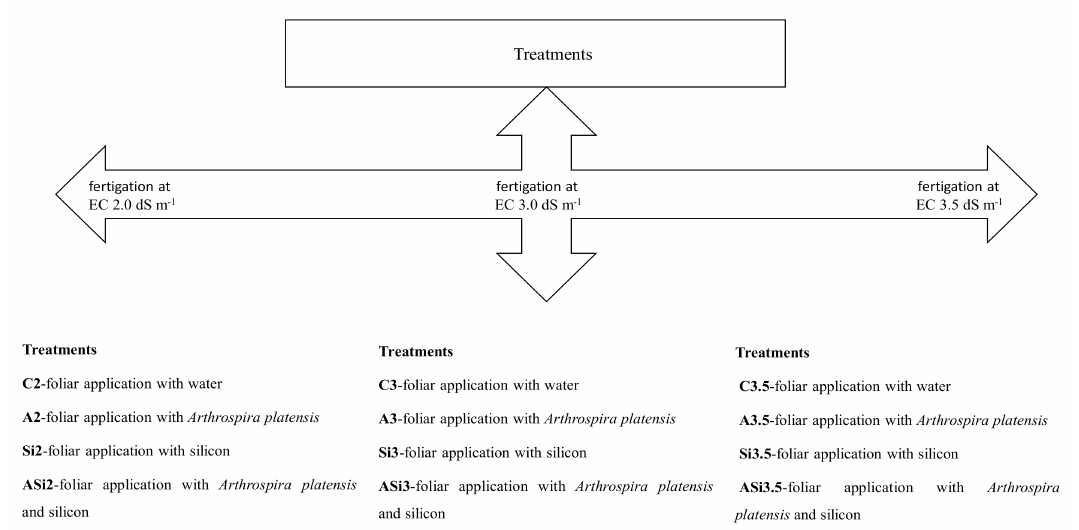
Figure 1. Schematic diagram of the treatments performed. C—foliar application with water; A—foliar application with Arthrospira platensis ; Si—foliar application with silicon; ASi—foliar application with Arthrospira platensis and silicon; 2—fertigation at EC 2.0 dS m − 1 ; 3—fertigation at EC 3.0 dS m − 1